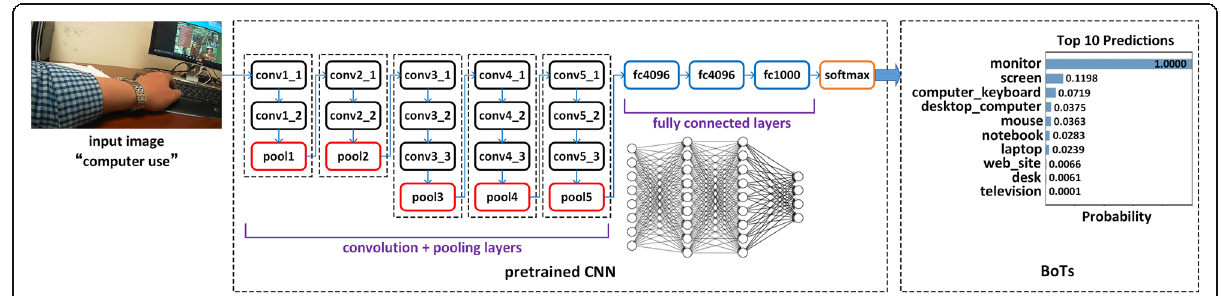
Fig. 2 The typical process of automatic image classification and annotation using pre-trained CNN